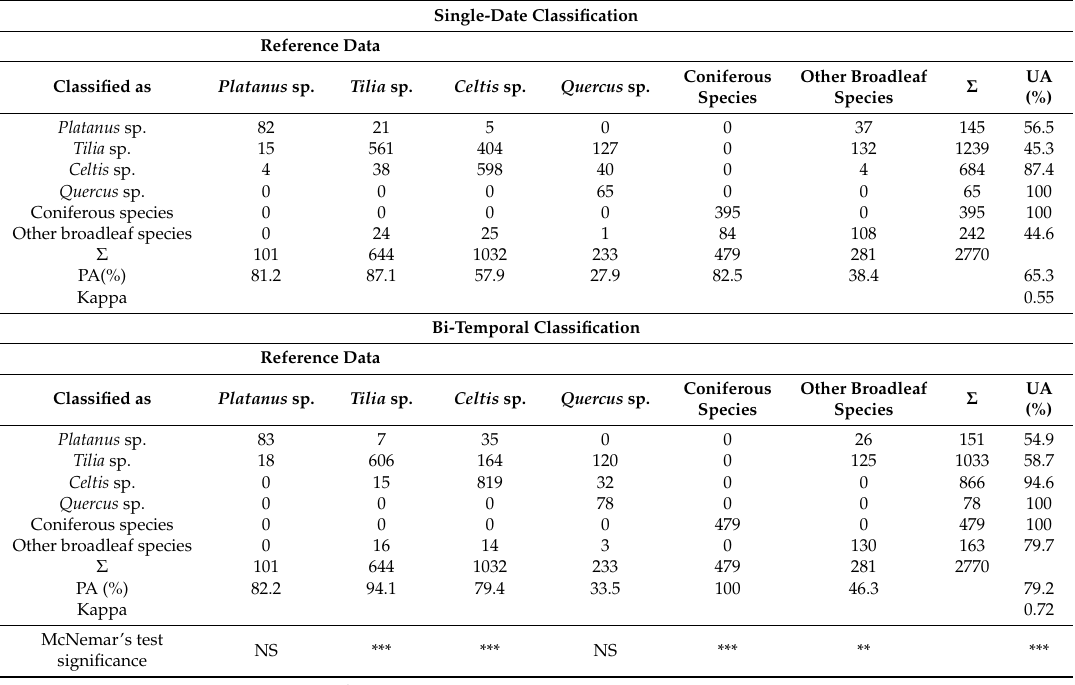
Table 7. Confusion matrices and statistical measures for the tree species classification with single-date and bi-temporal Pl é iades images using Random Forest